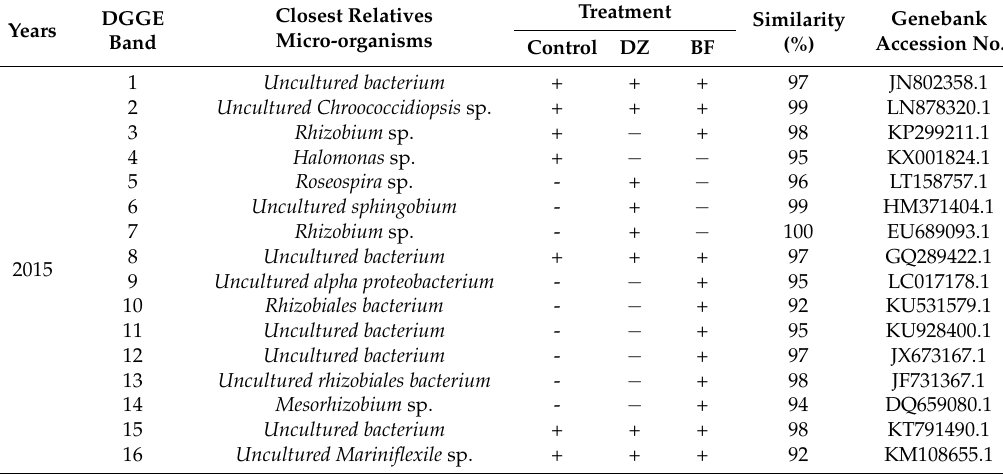
Table 4. Phylogeny of sequences present in the 16S rRNA amplicons